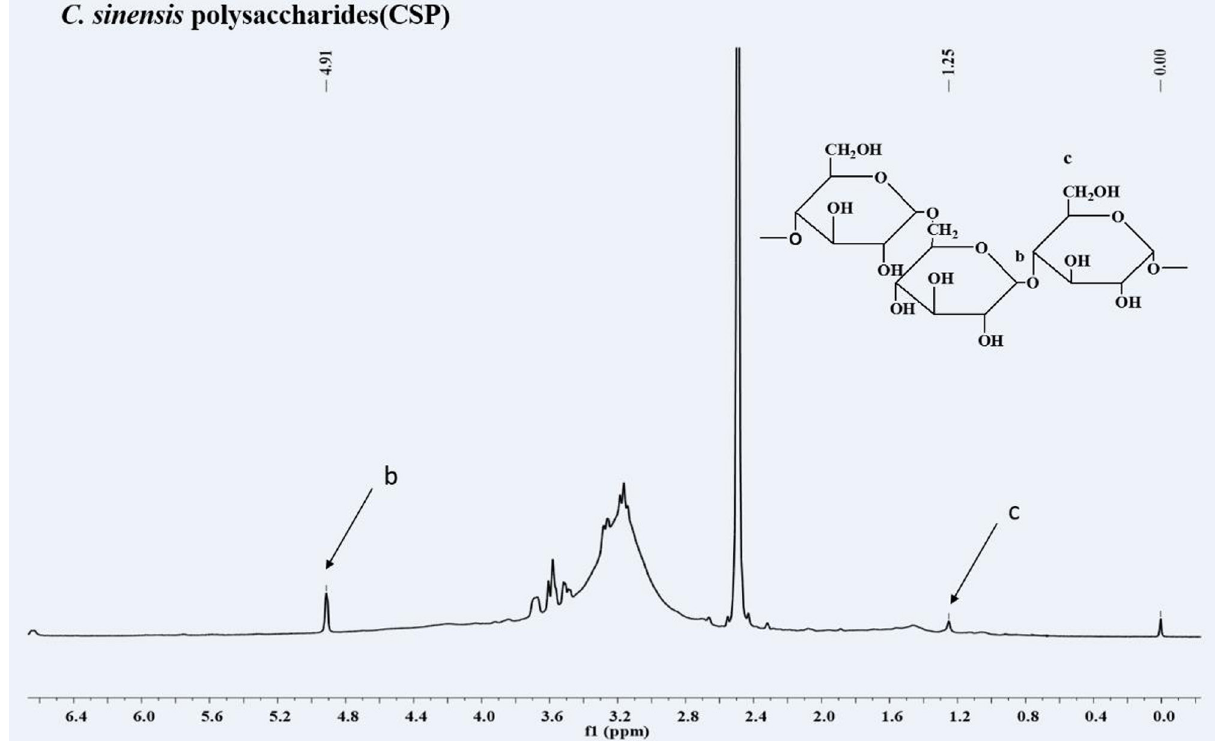
FIGURE 4 - 1 H nuclear magnetic resonance ( 1 H-NMR) spectra of CSP in DMSO